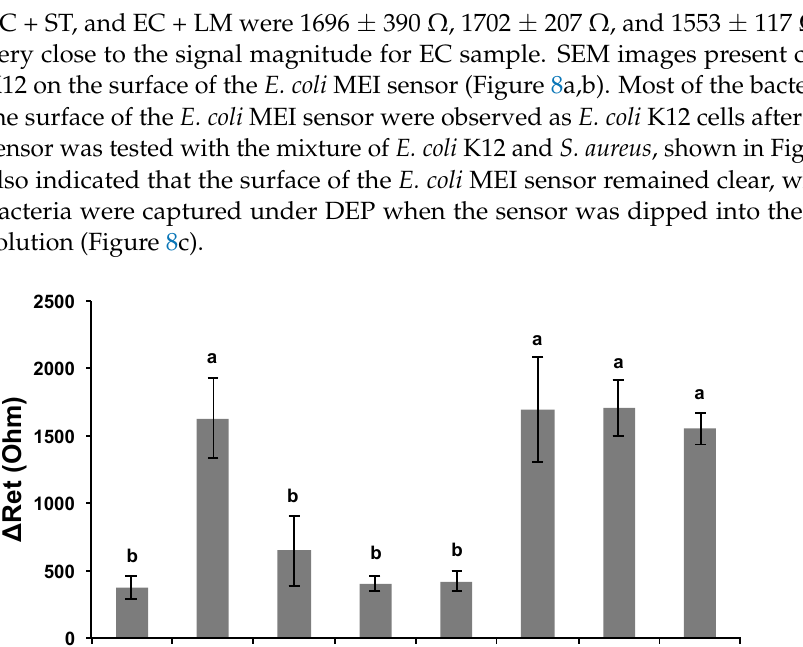
Figure 7. Specificity and selectivity of the E. coli MEI sensor for detection of E coli K12 against nontarget bacteria suspension and cocktail samples. Mean bacteria suspensions in pure and mixed samples. EC: E. coli K12, SA: S. aureus , ST: S. typhimurium , LM: L. monocytogenes , EC + SA: a mixture of E. coli K12 and S. aureus , EC + ST: a mixture of E. coli K12 and S. typhimurium , and EC + LM: a mixture of E. coli K12 and L. monocytogenes . Error bars indicate the standard deviation of the mean. Different letters (a and b) in the figure indicate significant differences ( p ≤ 0.05).